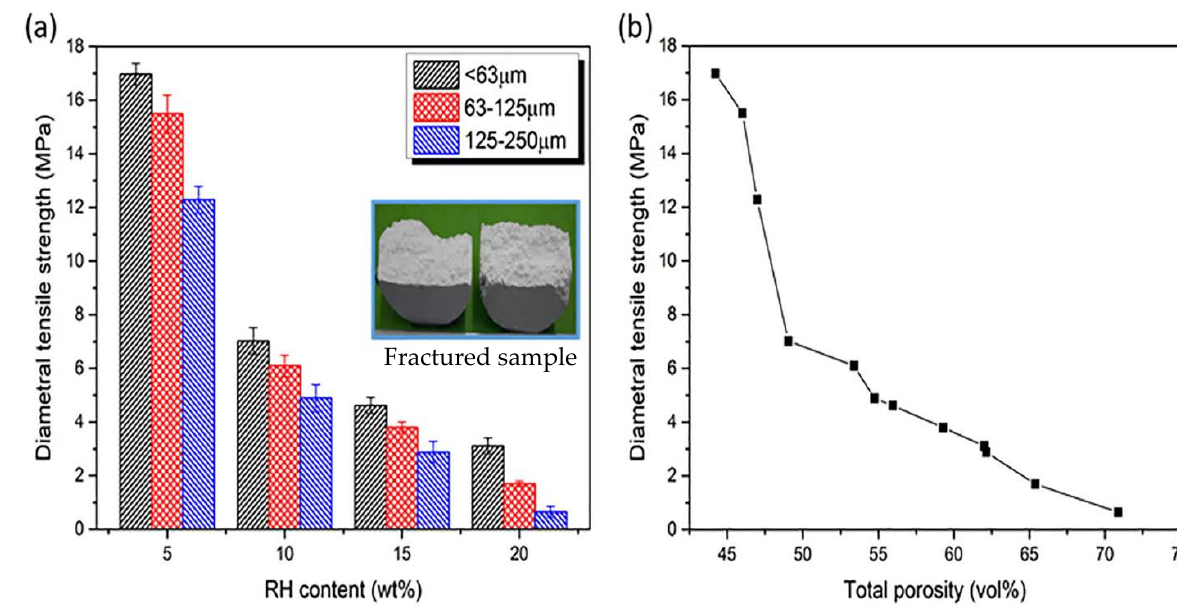
Figure 6. Diametral tensile strength of the porous Al 2 O 3 ceramics as a function of ( a ) RH addition and ( b ) total porosity.